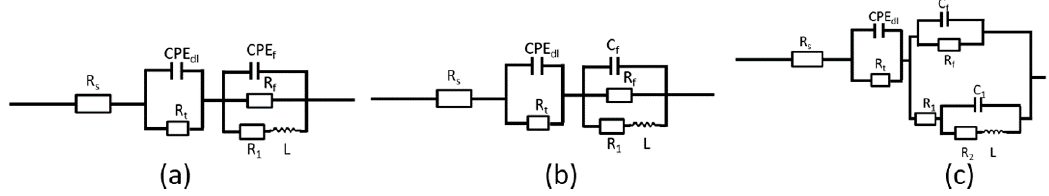
Figure 4. Equivalent circuits for AZ91D with different exposure time in simulated HA solution: ( a ) Model A, ( b ) Model B, ( c ) Model C.